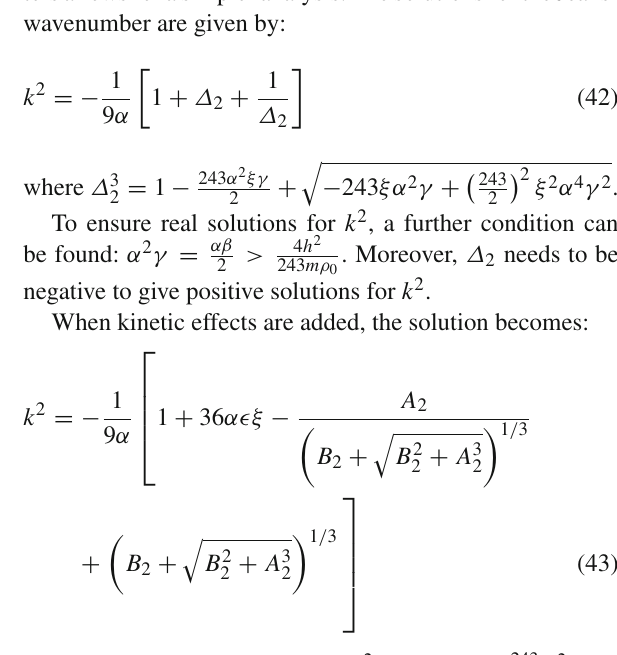
Fig. 2 Behavior of the squared modified Jeans’ wavelength with only quantum correction, or with quantum and kinetic effects for a pure non- minimal matter-curvature coupling